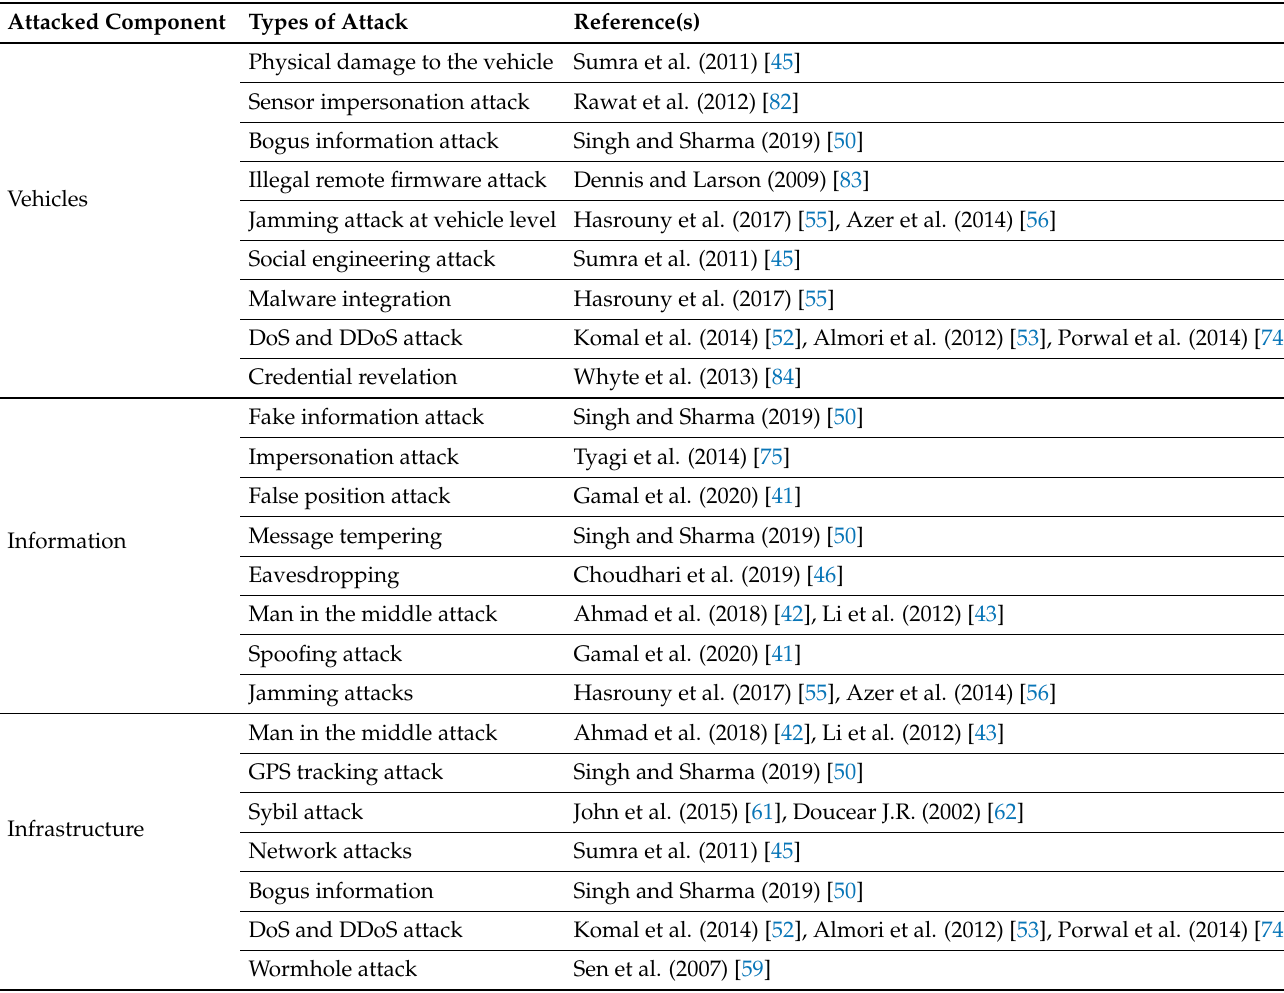
Table 4. Attack classification based on different VANET